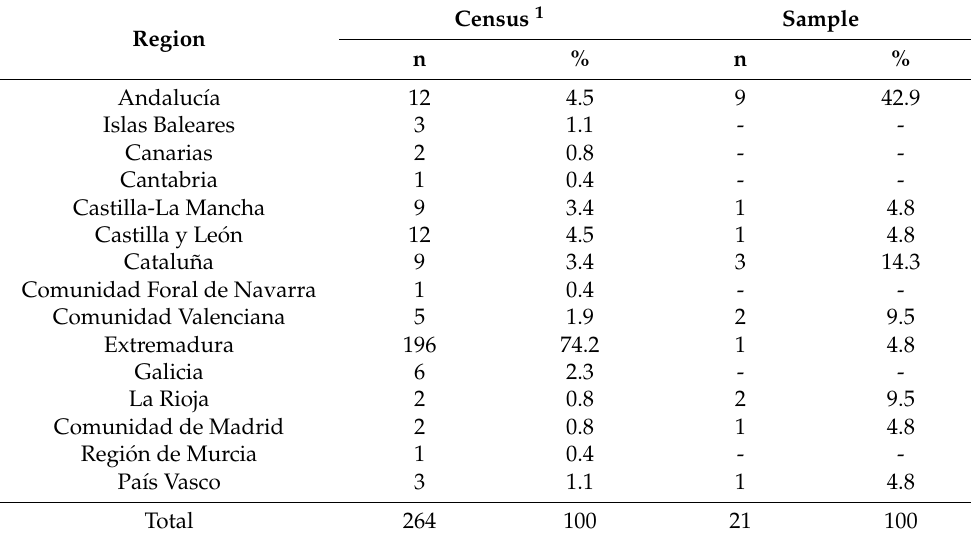
Table 1. Regional distribution of the Spanish quail game farms, according to the census (in 2018), and the sample of farms surveyed in this